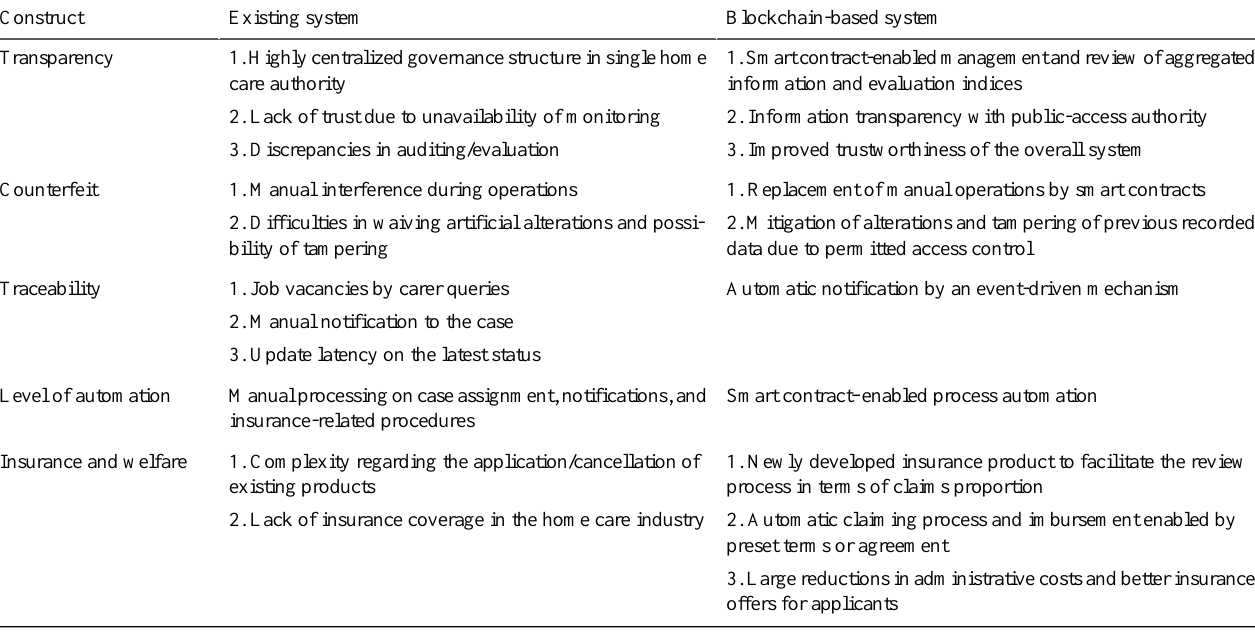
Table 1. Comparison of constructs between the existing system and the proposed system.